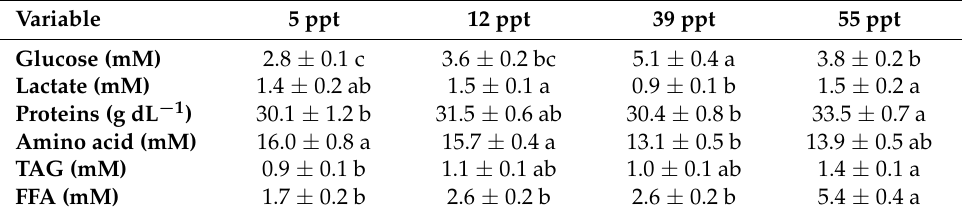
Table 1. Plasma metabolites of A. regius juveniles acclimated to different environmental salinities (5, 12, 39, and 55 ppt) for 21 days. Data are expressed as the mean ± standard error of the mean (SEM) ( n =